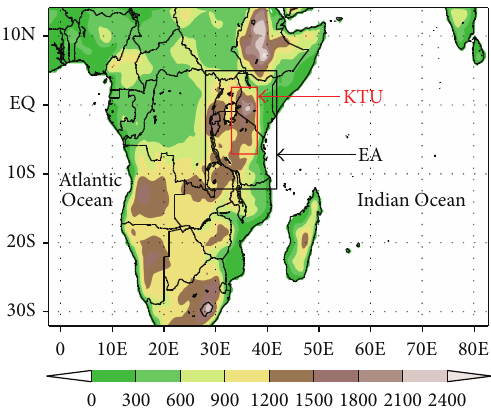
Figure 1: The model domain and elevation (in m). The rectangle (EA) is the area of study (east Africa), located over longitudes 28 ∘ E– 42 ∘ E and latitudes 12 ∘ S–5 ∘ N. The inner rectangle (red) is the area (KTU) over which topography is reduced [34 ∘ E–38 ∘ E, 6 ∘ S–2 ∘ N] in the sensitivity